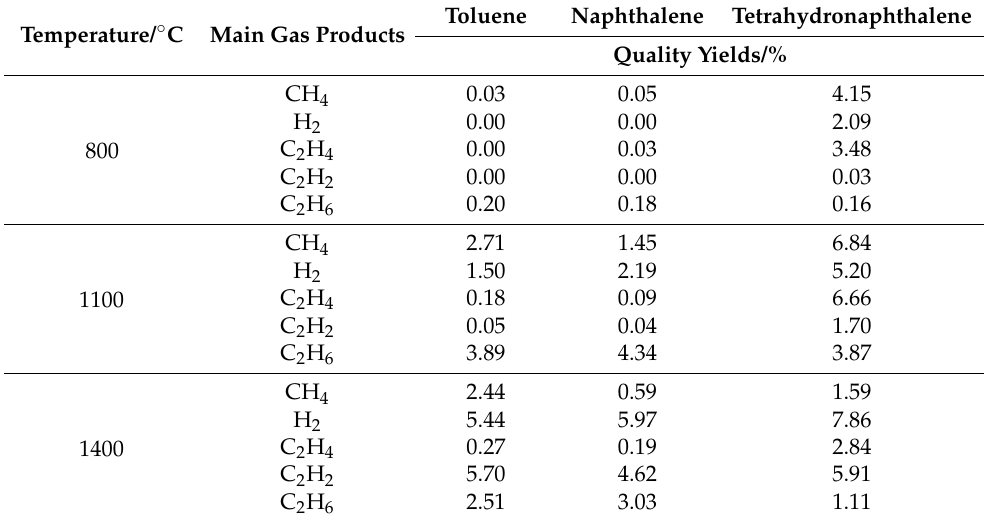
Table 2. The main gas product distribution of the model compounds at different temperatures. Toluene Naphthalene Tetrahydronaphthalene Temperature/ ◦ C Main Gas Products Quality